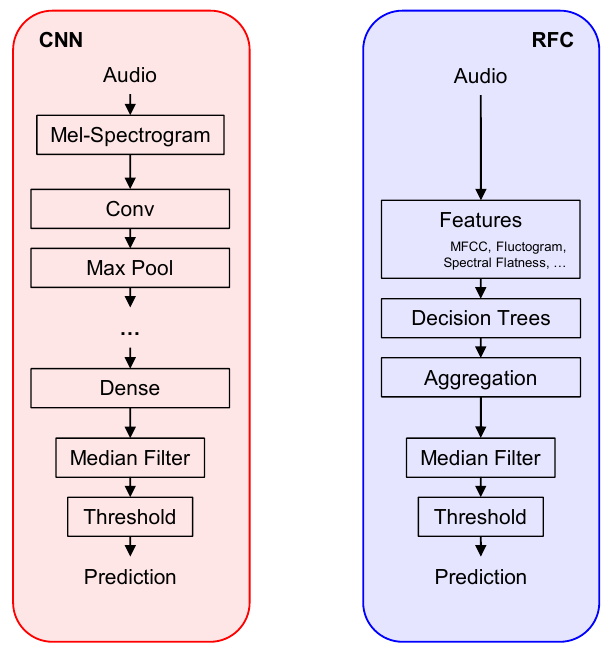
Figure 1. Conceptual overview of the two methods for singing voice detection considered in this paper. While the CNN-based approach operates directly on mel-spectrogram excerpts, the RFC requires an additional feature extraction step. Both approaches output continuous predictions which are post-processed using a median filter and thresholding. The exact architecture of the CNN is omitted for brevity. We refer to the original publications for